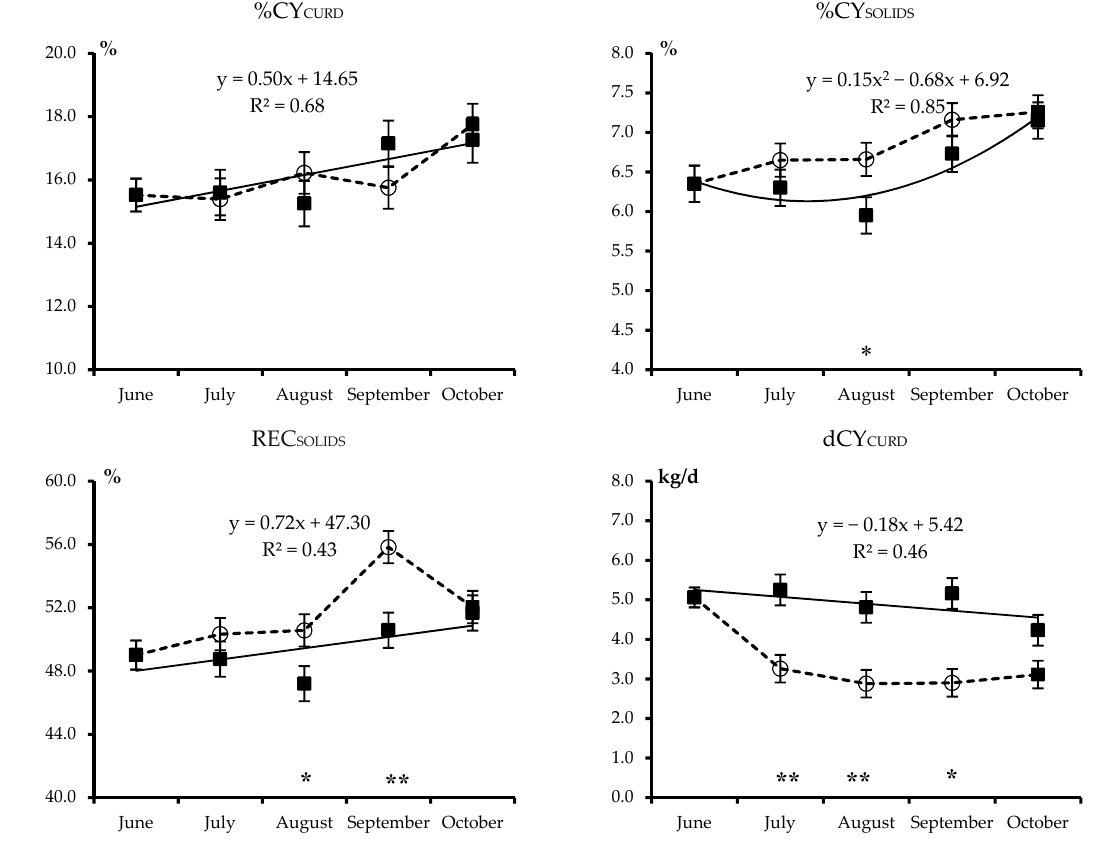
Figure 4. Least squares means and standard error of the combined Treatment × Month effect for fresh cheese yield (%CY CURD ), total solids cheese yield (%CY SOLIDS ), milk solids recovered in the curd (REC SOLIDS ), and daily production of curd (dCY CURD ) of Brown Swiss cows kept on permanent farm ( ■ and continuous line) or moved to highland summer pasture from July to September ( ○ and dotted lines). Equations describe the trends of month within permanent farm (R 2 is shown). Asterisks refer to significant differences between cows moved to highland summer pasture and those kept on the permanent farm in a given month (* p < 0.05 or ** p < 0.01).